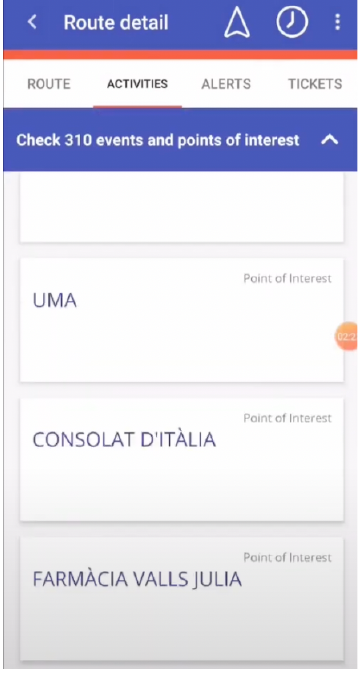
Figure 7. My-Trac suggestions.